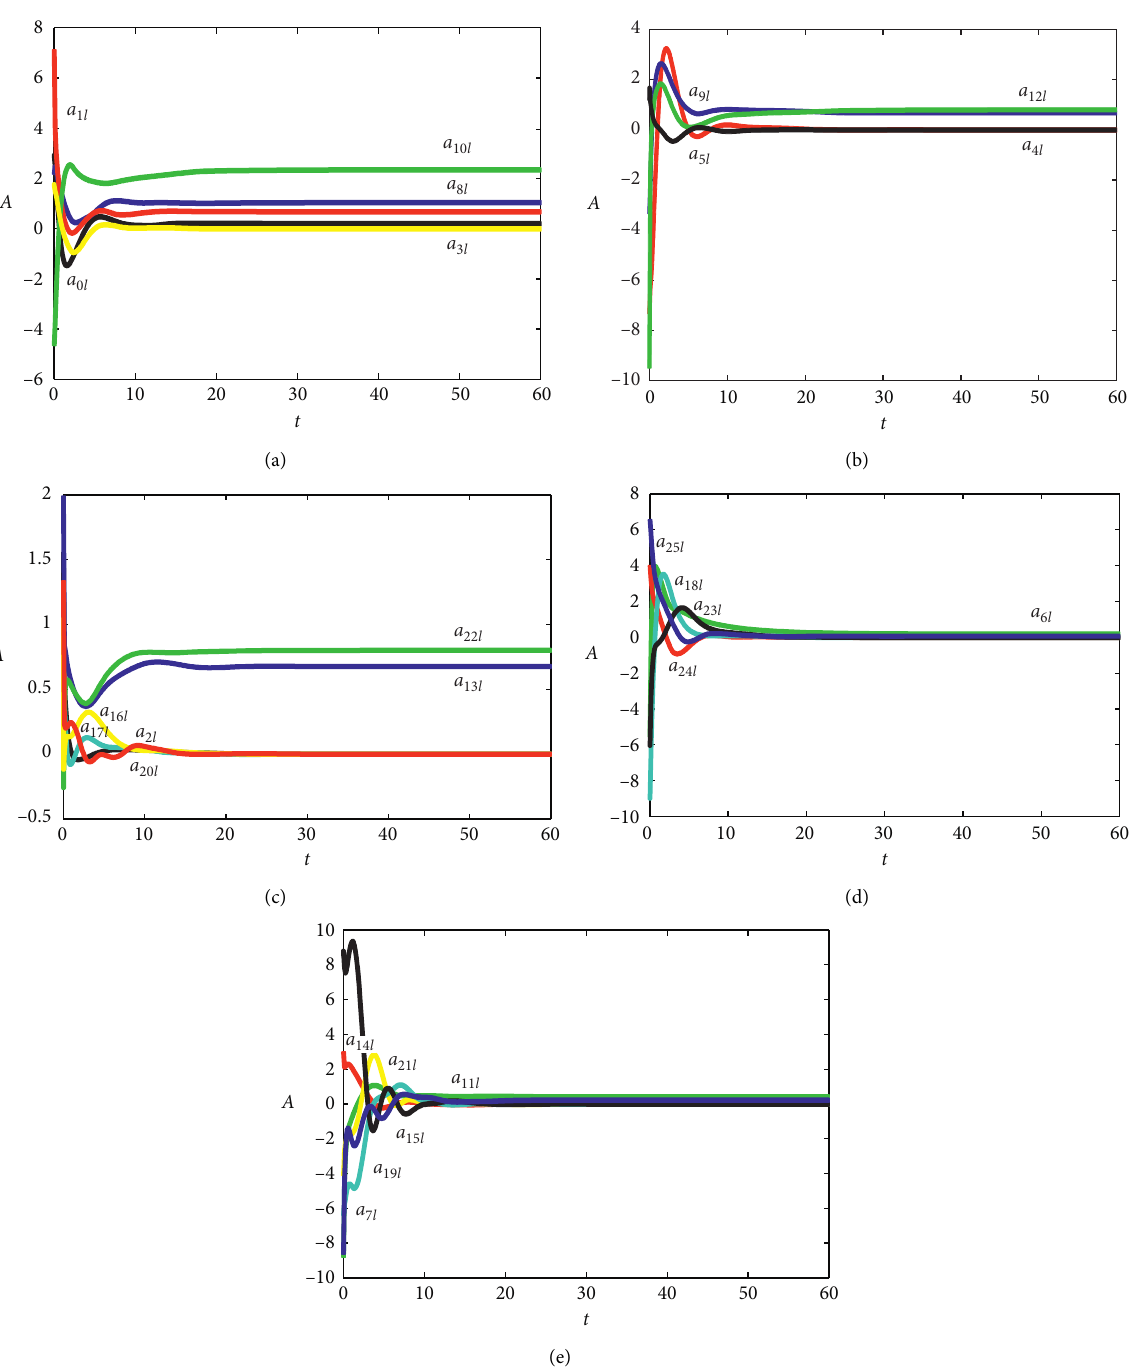
, a , .. . ,a for neural network (53) and (54) in Example 0 l 1 l 25 l